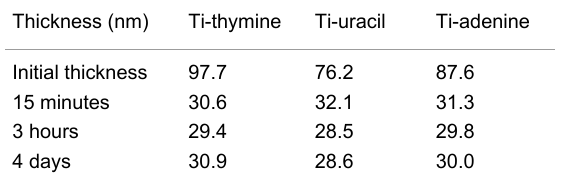
Table 2: Film thickness (nm) after 15 minutes, 3 hours and 4 days of exposure to water as measured by spectroscopic ellipsometry for Ti-thymine (at 225 °C), Ti-uracil (at 225 °C), Ti-adenine (at 250